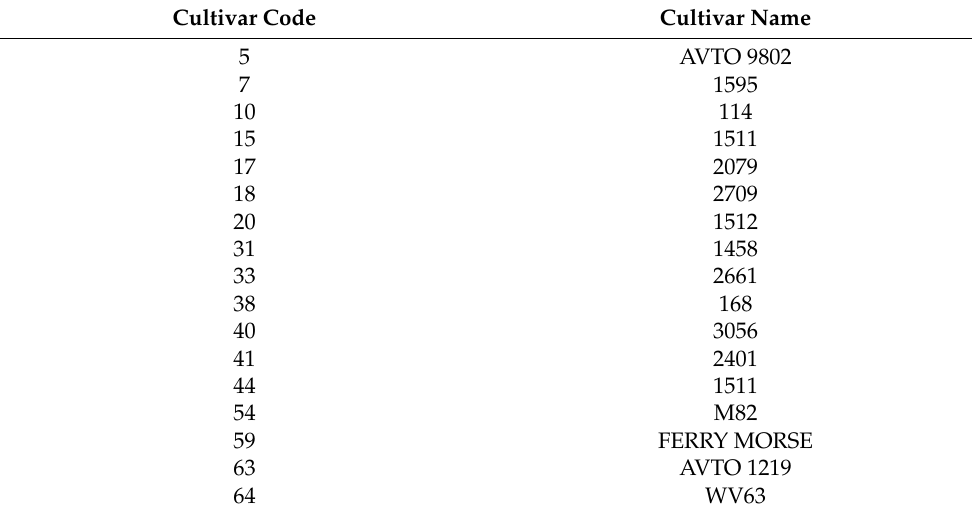
Table 1. Codes and names of 17 tomato cultivars tested for suppressive ability on Palmer amaranth, yellow nutsedge, and large crabgrass.